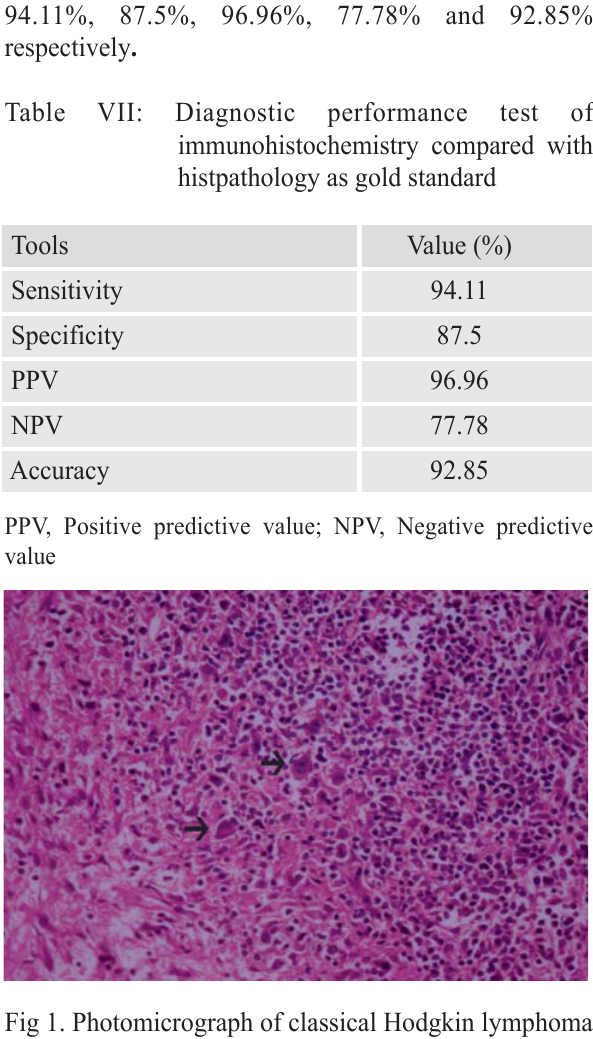
Fig 1. Photomicrograph of classical Hodgkin lymphoma